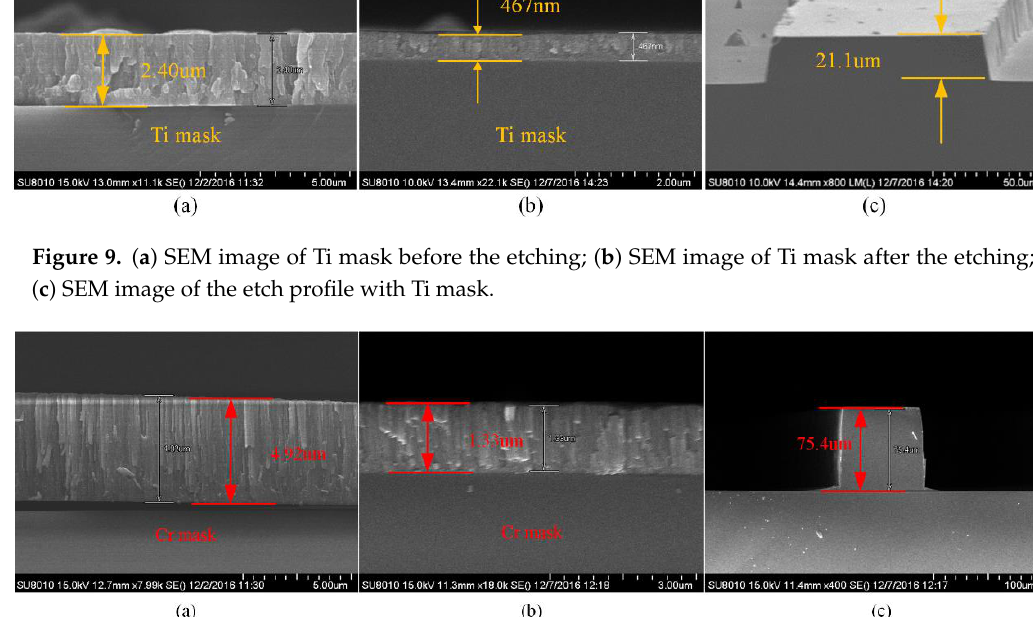
Figure 10. ( a ) SEM image of Cr mask before the etching; ( b ) SEM image of Cr mask after the etching; ( c ) SEM image of the etch profile with Cr mask.